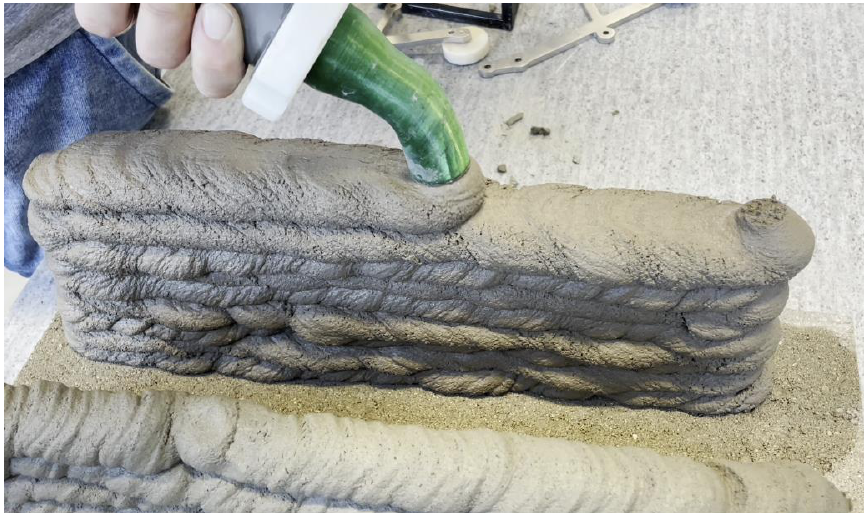
Figure 8. The process of extruding a line onto a solid, moistened surface. If it is possible to extrude the mixture in ten or more layers without collapsing, the mixture is marked as having met the requirements of the buildability test. Examples of mixtures that failed (Figure 9) and passed (Figure 10) the test requirements are shown in the images below.